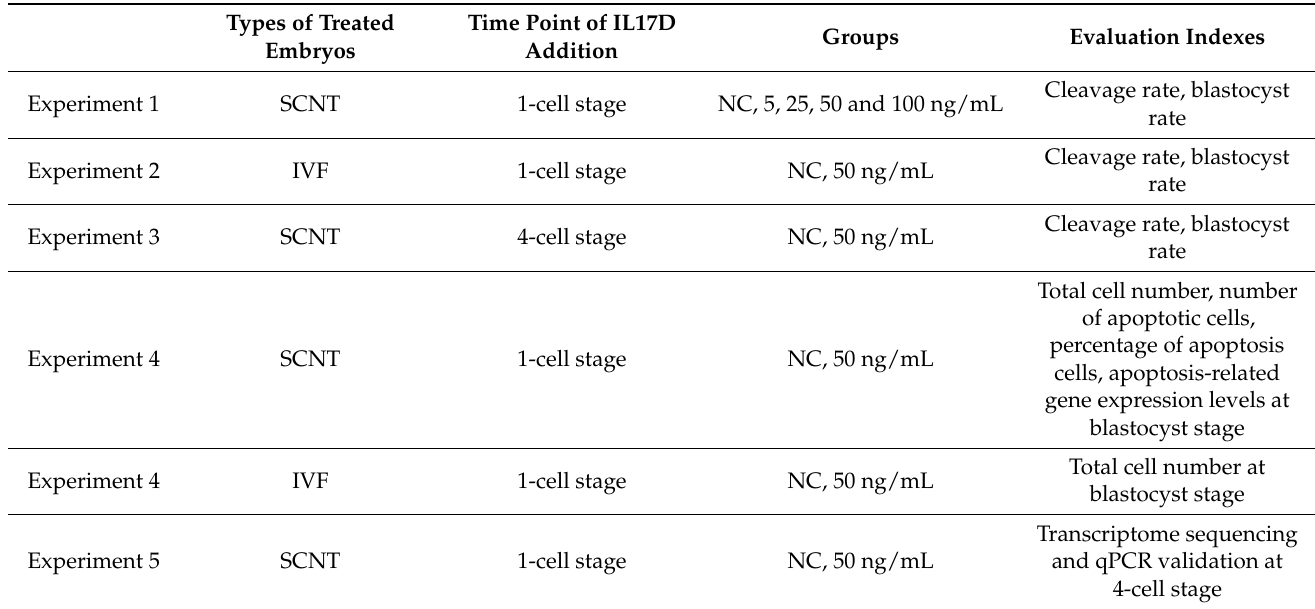
Table 1. Experimental design of IL17D treatment of